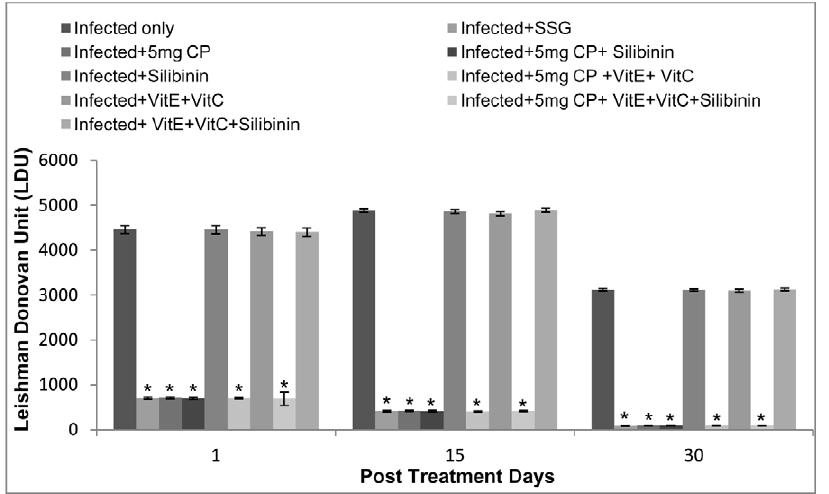
Figure 1. Parasite load in terms of LDU in different groups of animals. The data are presented as mean 6 S.D. of six mice per group. * -p value: Infected only vs Infected + SSG/Infected + 5 mg CP/Infected + 5 mg CP + Silibinin/Infected + 5 mg CP + VitE + VitC/Infected + 5 mg CP + VitE + VitC + Si- libinin.* - p , 0.001. No significant difference was found in groups: Infected + 5 mg CP vs Infected + 5 mg CP + Silibinin/Infected + 5 mg CP + VitE + VitC/ Infected + 5 mg CP + VitE + VitC + Silibinin and Infected only vs Infected + Silibinin/Infected + VitE + VitC/Infected + VitE + VitC + Silibinin. LDU- Leishman